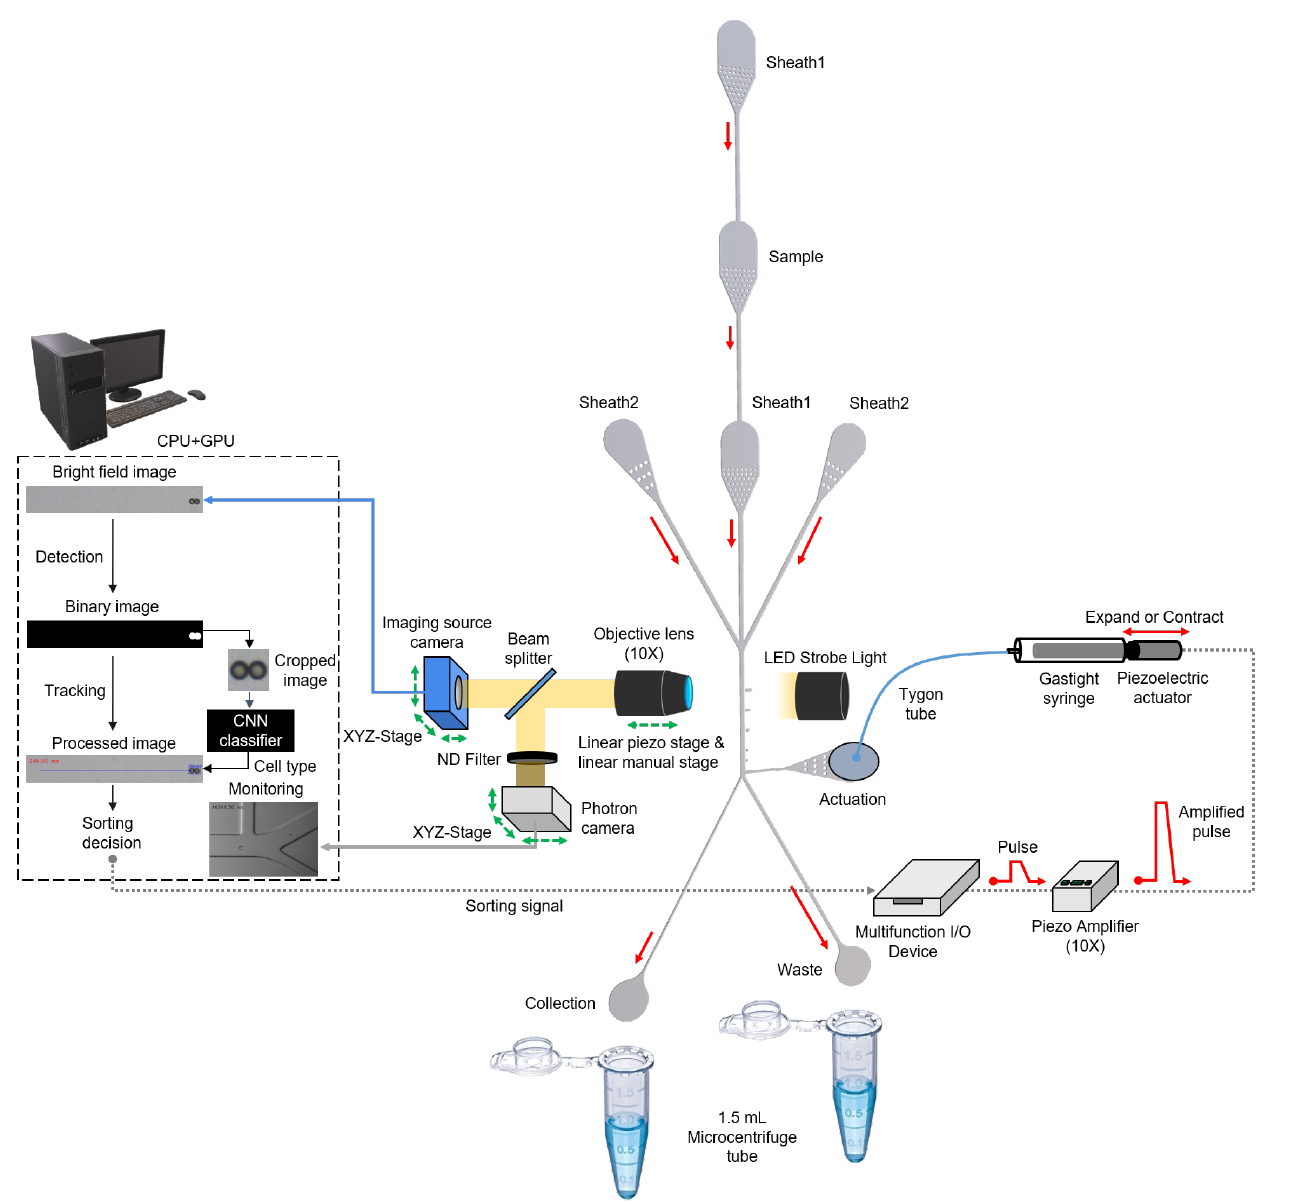
Figure 1. Schematic of upgraded user-friendly image-activated microfluidic cell sorter. The real-time sorting mechanism has not changed significantly compared to the previous system [15]. The vertically and horizontally focused cells are analyzed as they flow through the detection region. Target and non-target cells are sorted into the collection and waste channels based on the classified cell